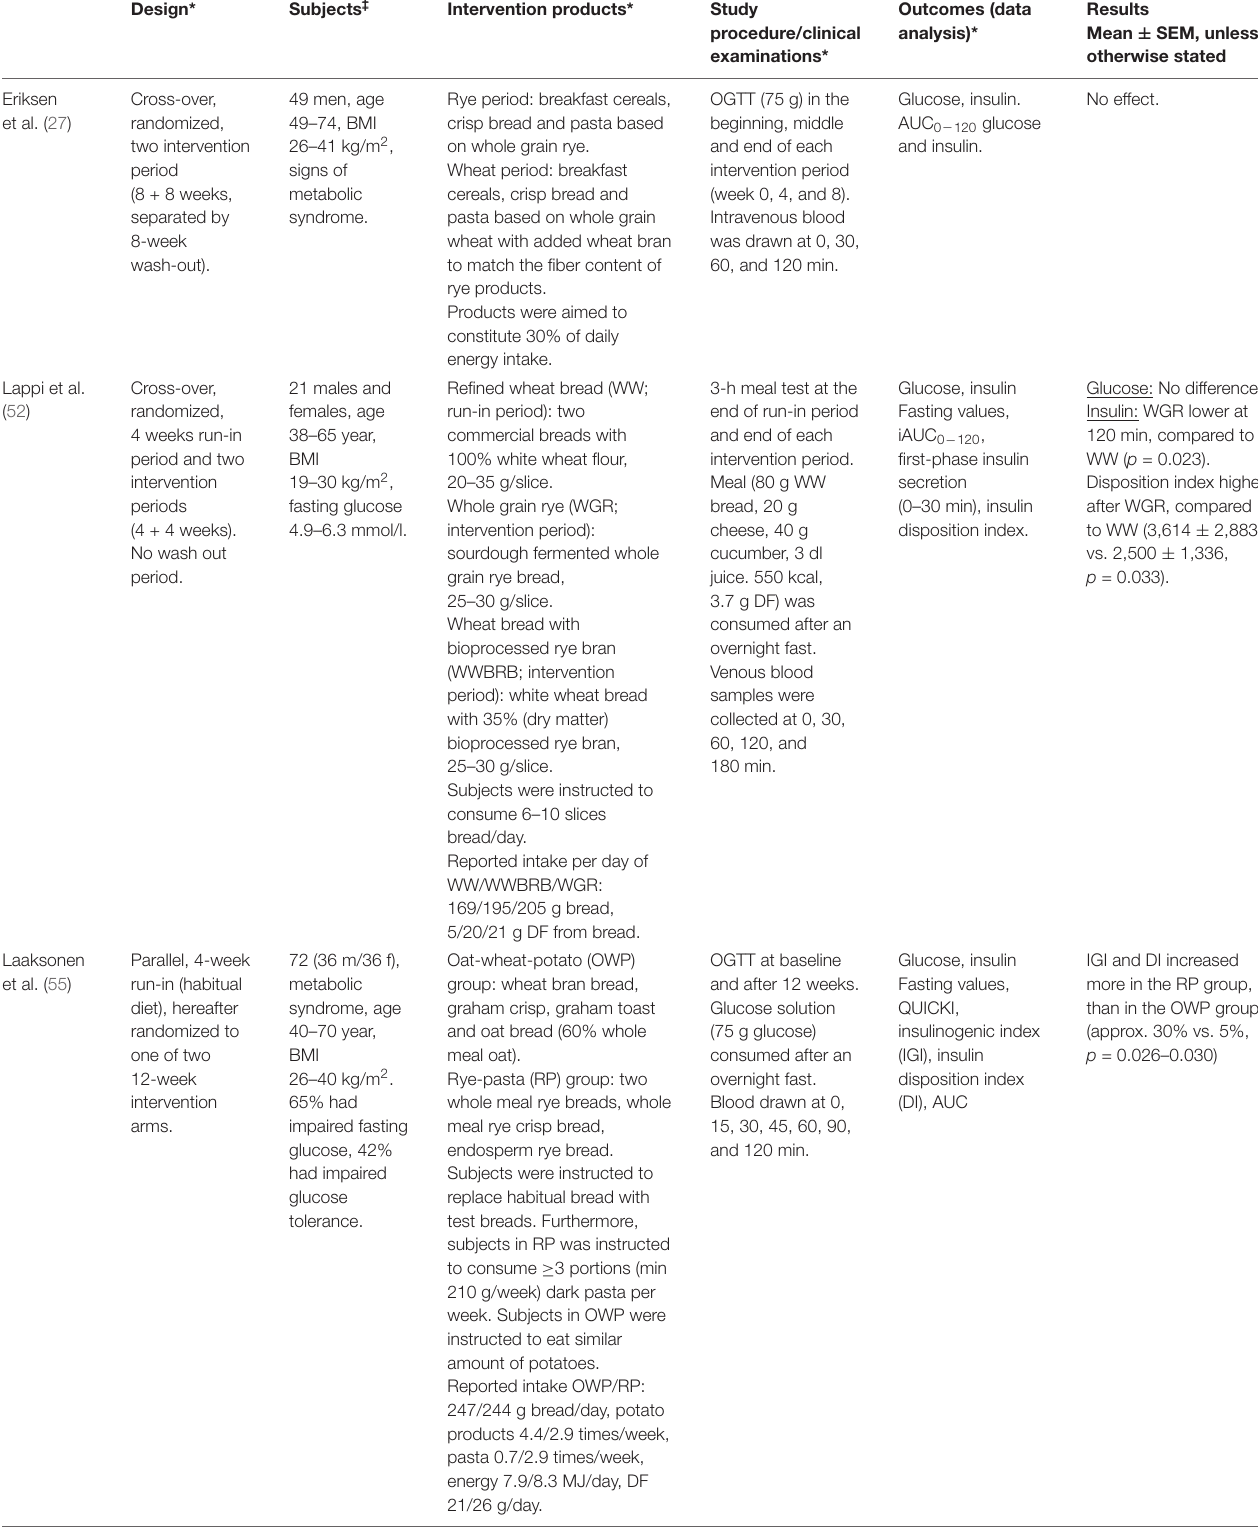
TABLE 3 | Studies investigating the effect on habitual consumption of rye products on glycemic control.